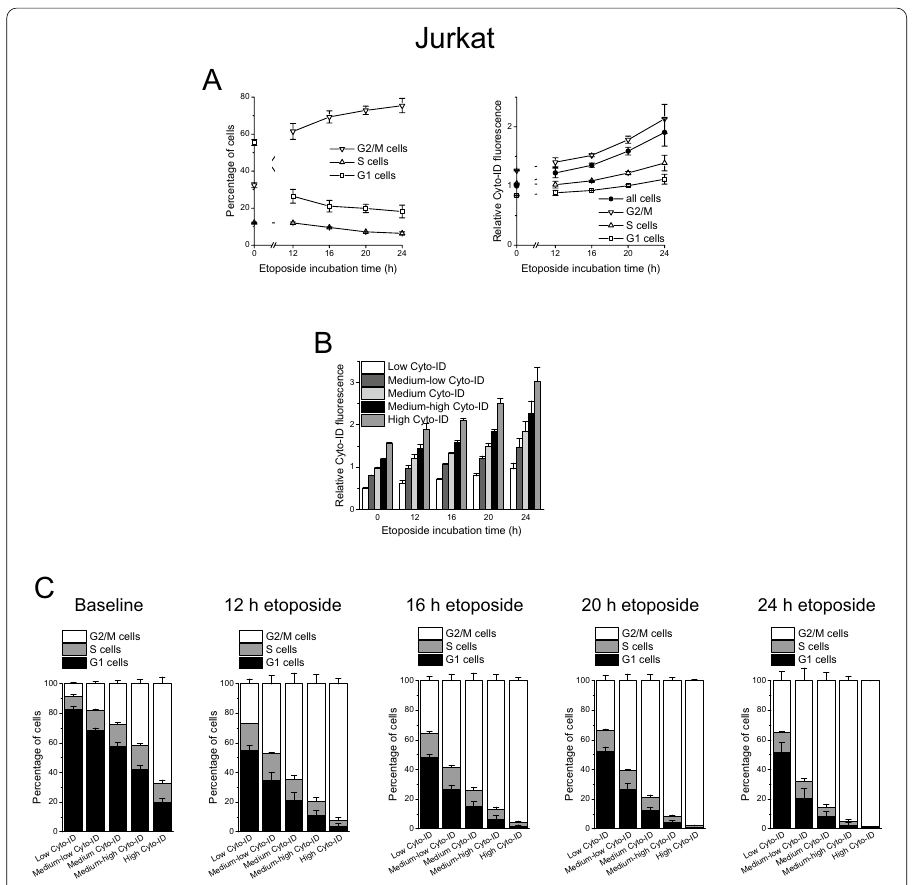
Fig. 4 Cell cycle phase and autophagy are tightly associated. Cells were exposed to 0.2 µM etoposide for the indicated times. Autophagy and cell cycle phases were determined by flow‑cytometric analysis of Cyto‑ID DRAQ5 double‑stained cells. A Effect of etoposide on cell cycle phase distribution and autophagy. + B, C Cell populations were grouped into quintiles based on their Cyto‑ID fluorescence intensities (Fig. S3A). B Relative Cyto‑ID fluorescence intensities of the quintiles of cells. Cyto‑ID fluorescence intensities were normalized to the mean Cyto‑ID fluorescence intensity of untreated cells. C Cell cycle phase distribution in the quintiles of cells. Mean SEM of two (12‑h and 16‑h treatment) or three independent measurements is ±